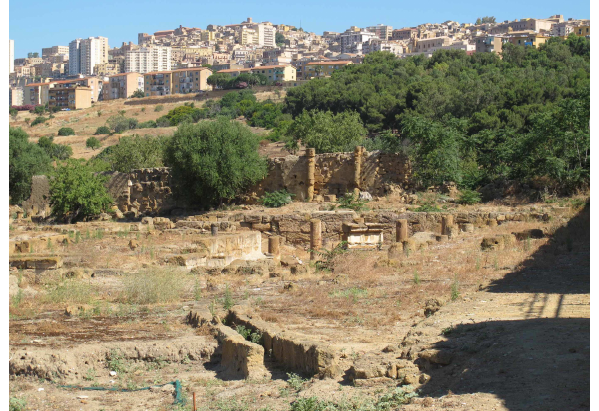
Figure 3. The Temple of Isis